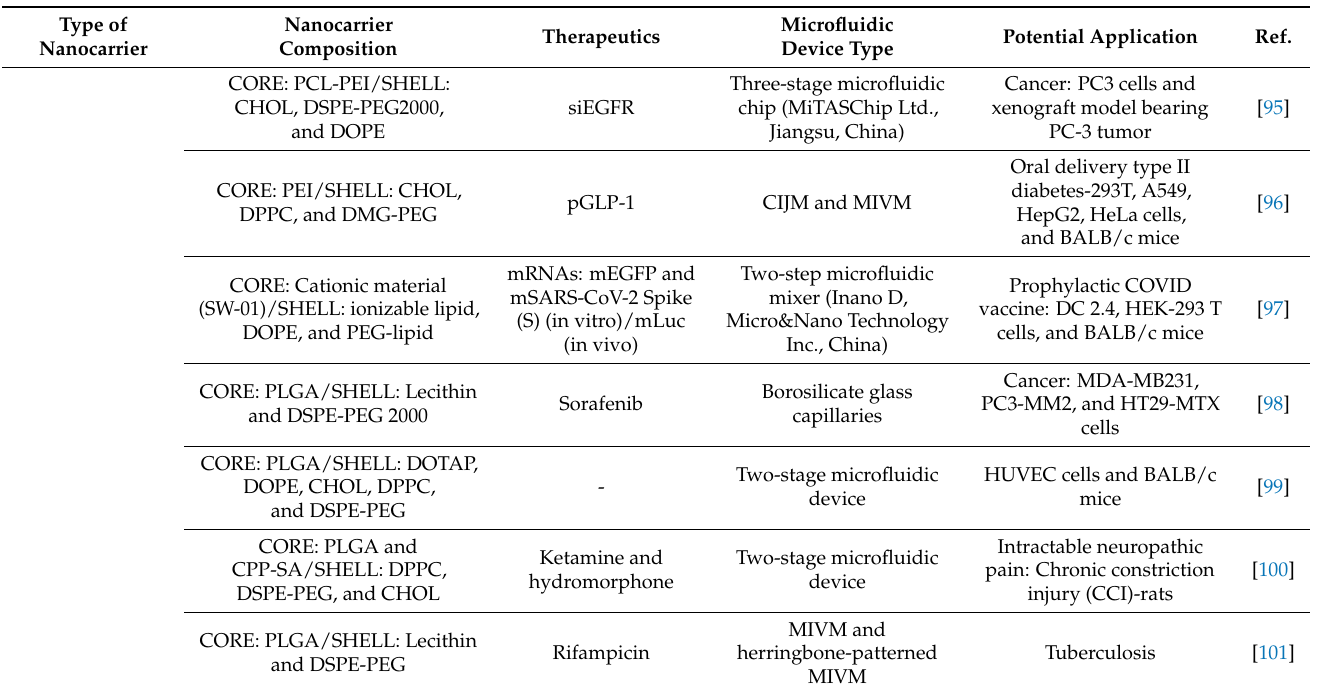
Table 2. Nanocarrier systems (core/shell NPs and exosomes) produced by microfluidics for drug and gene